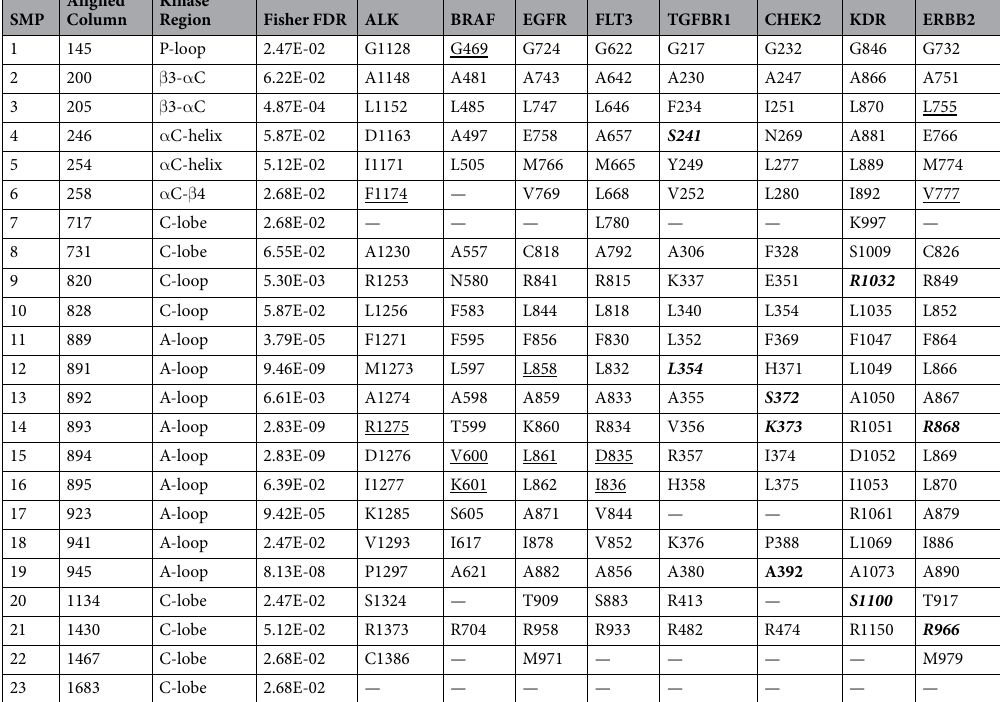
Table 1. Significantly Mutated Positions. The 23 significantly mutated positions are listed, as well as their aligned position, kinase region and final Fisher FDR. The corresponding residues from several well-known protein kinases, as well as kinases used in this study are also indicated. Kinase regions β 3- α C and α C- β 4 refer to the β 3- α C loop and α C- β 4 loop, respectively. Positions bearing well-known functional mutations are underlined; positions corresponding to mutations to be tested in vitro are bolded and italicized. The complete listing of aligned positions and corresponding positions for all genes are in Supplementary Table 4, and additional summary statistics for the 23 SMPs are in Supplementary Table